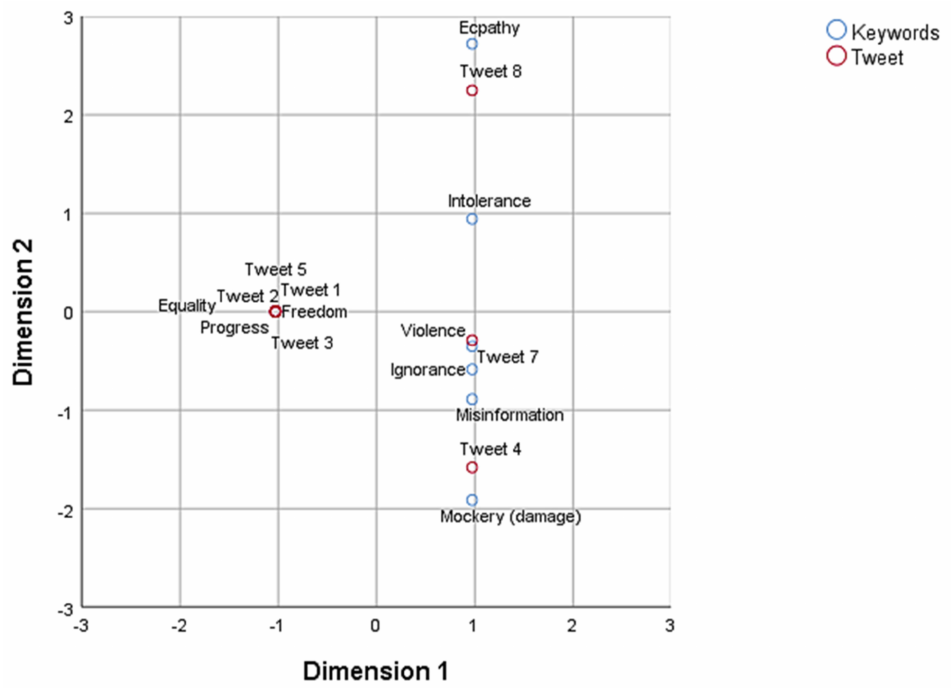
Figure 5. Positions of keywords and